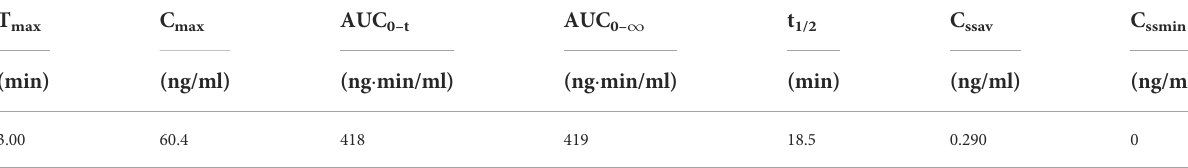
TABLE 3 Pharmacokinetic parameters of BPC157 in rats following repeat intramuscular administration of 100 μ g/kg BPC157 for seven consecutive days (mean ± SD, n =